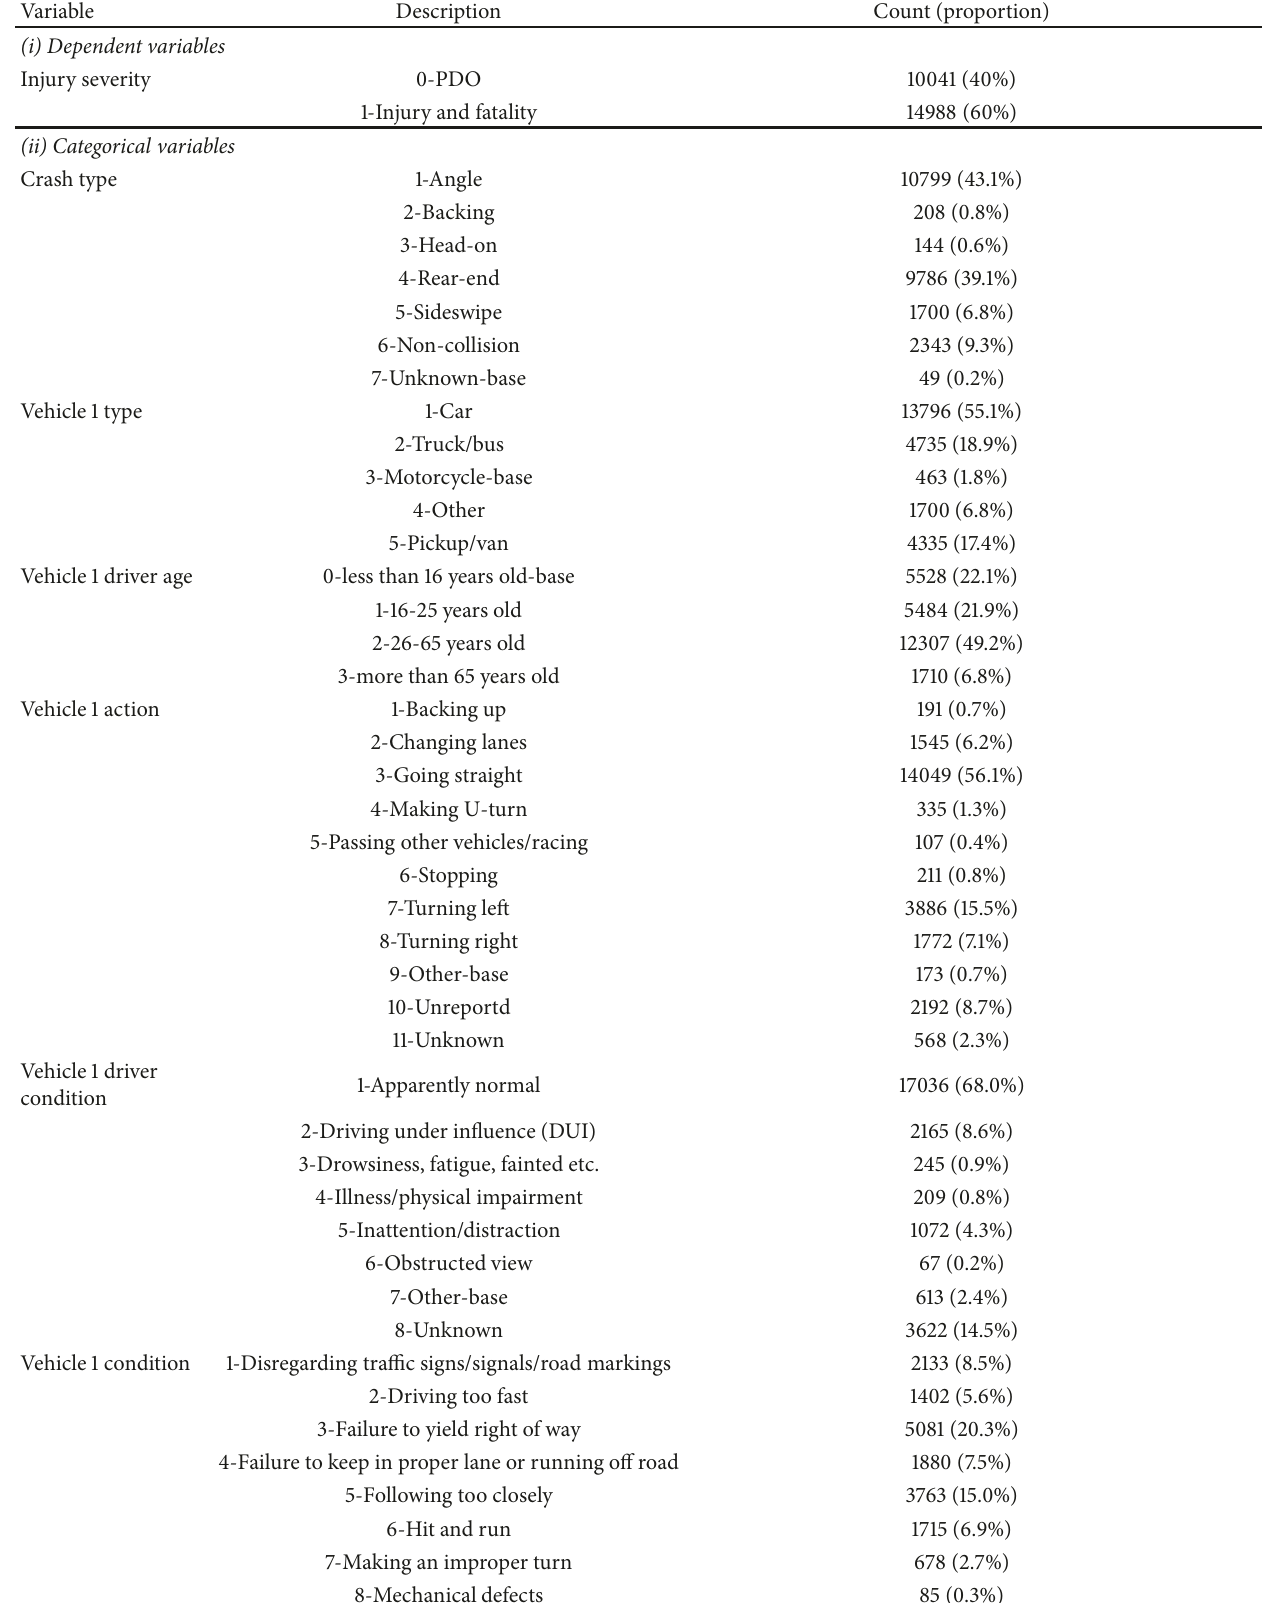
Table 1: Summary of the